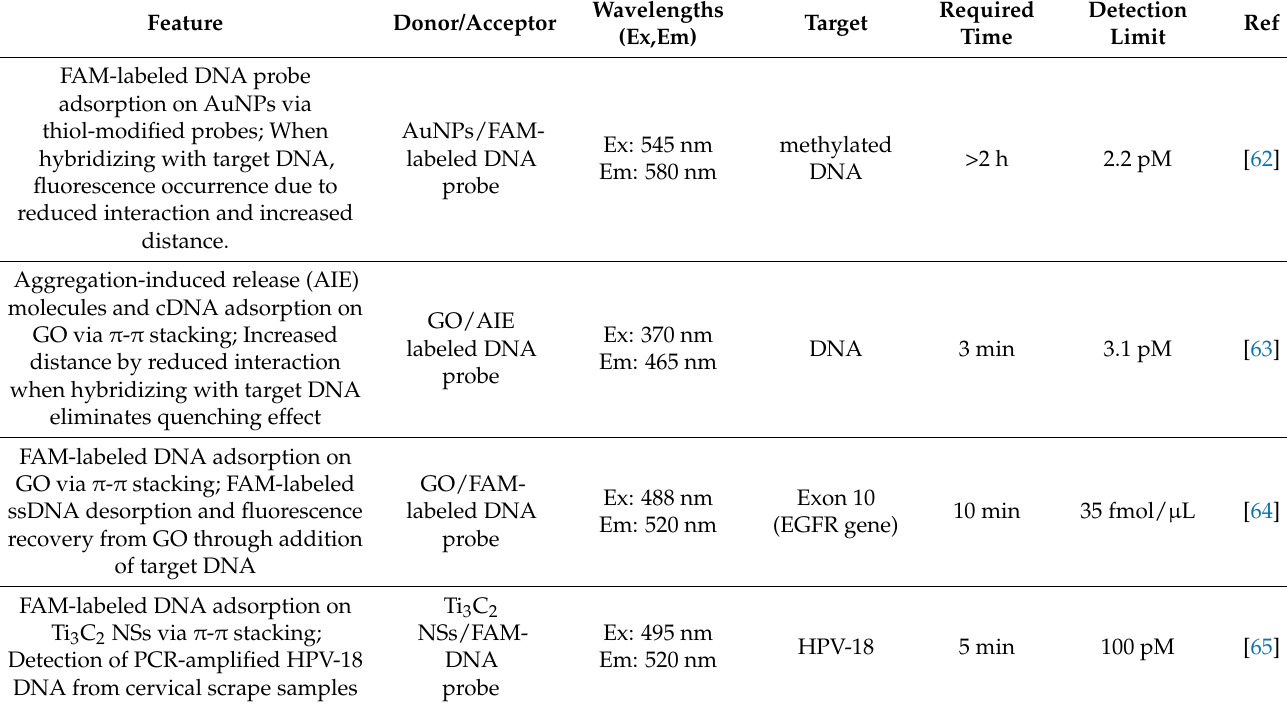
FAM-labeled DNA